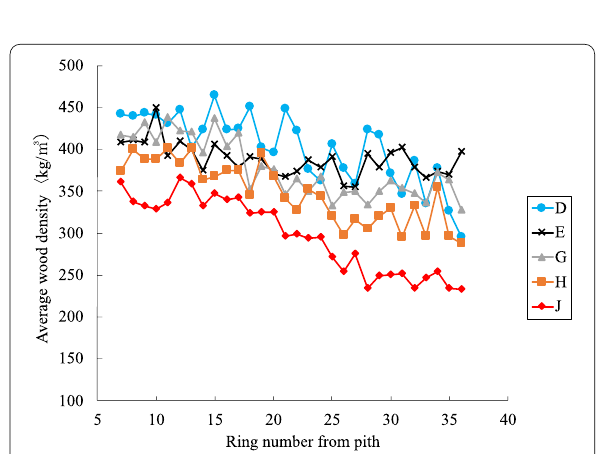
Fig. 5 Effects of initial tree density on average wood density. Each plot shows an average value in a ring number among sample trees of each tree density zoning symbol. Number of sample trees of each initial tree density zoning symbol range from five to nine. Initial tree density zoning symbols were the same, as shown in Table 1.